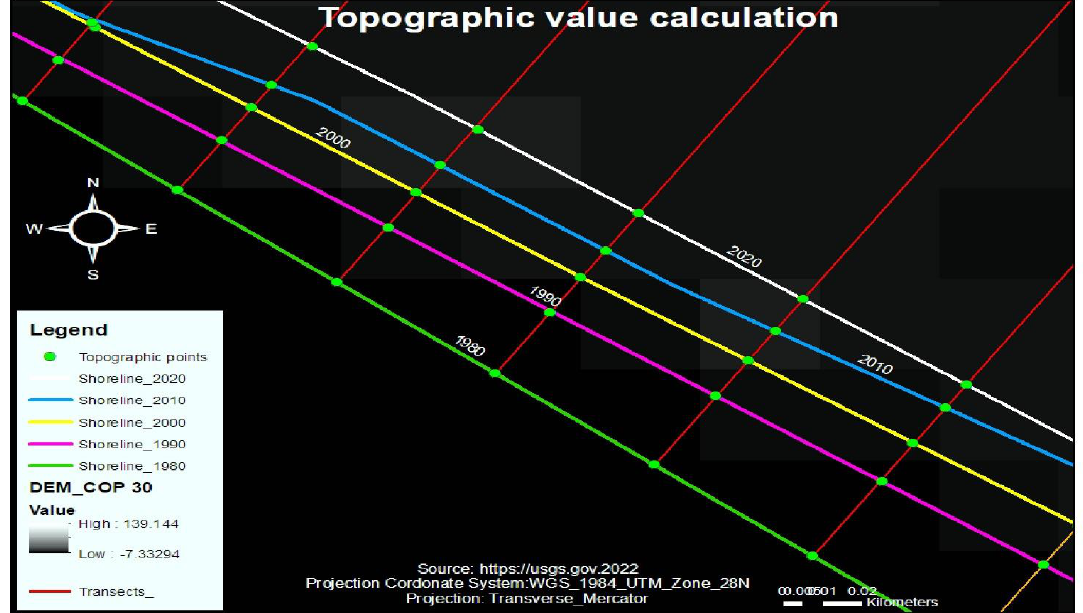
Figure 7. Determination of the topographic values in the study area. Source : GLO-30 DEM.